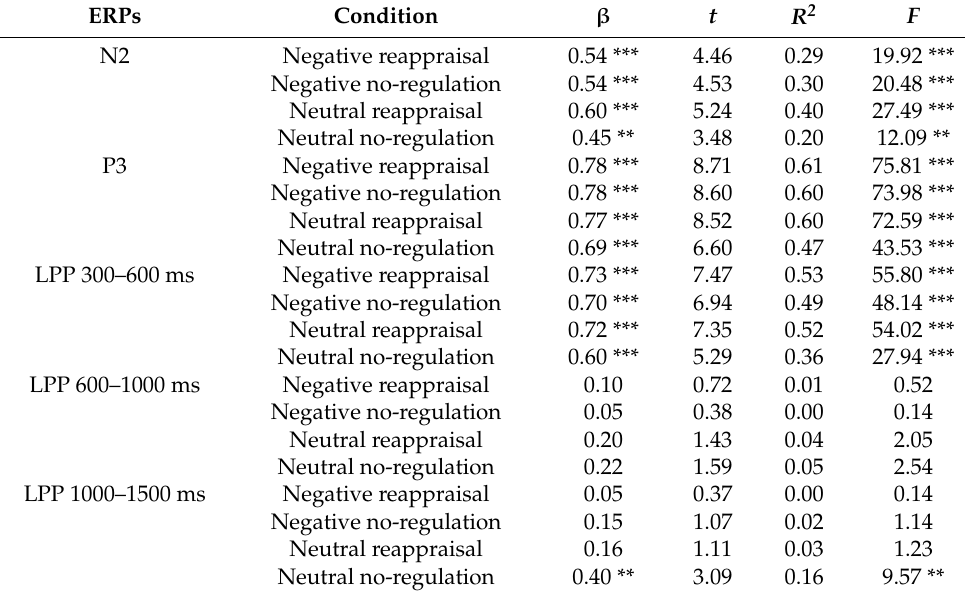
Table 4. Regression Analyses of Immediate and Lasting Effects of Emotion